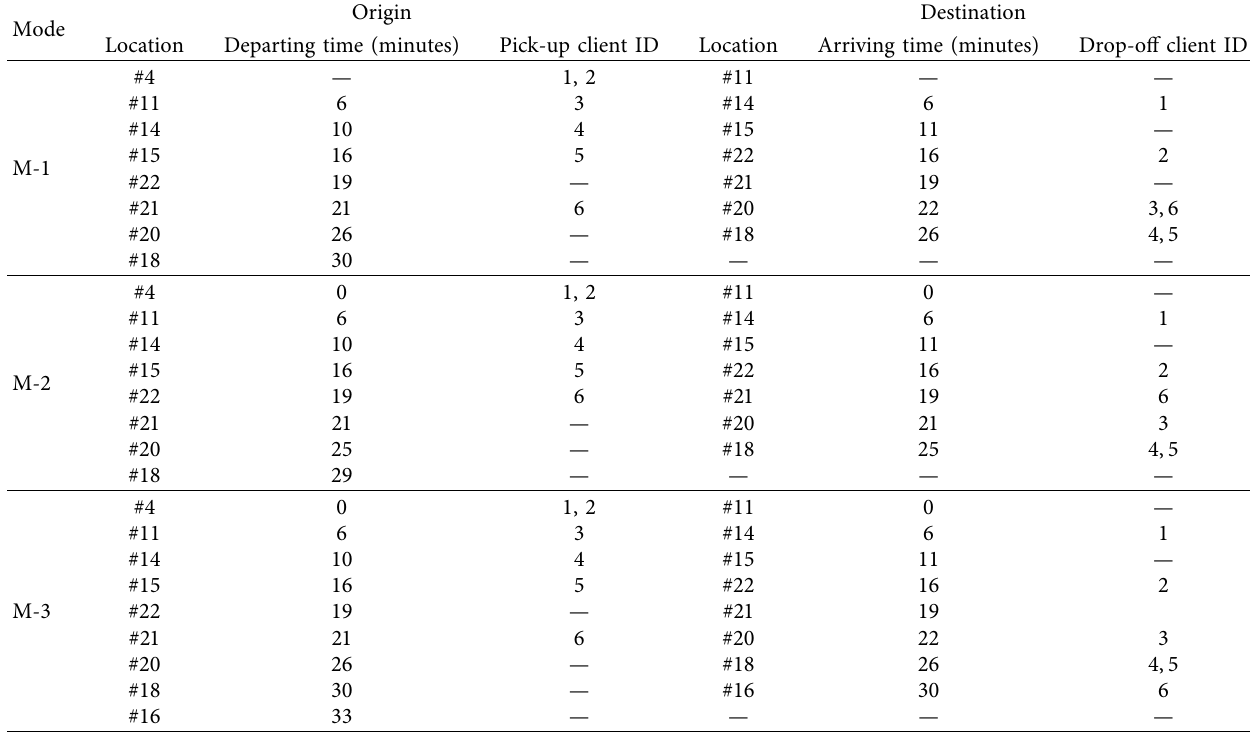
Table 2: Results of CB optimization models.